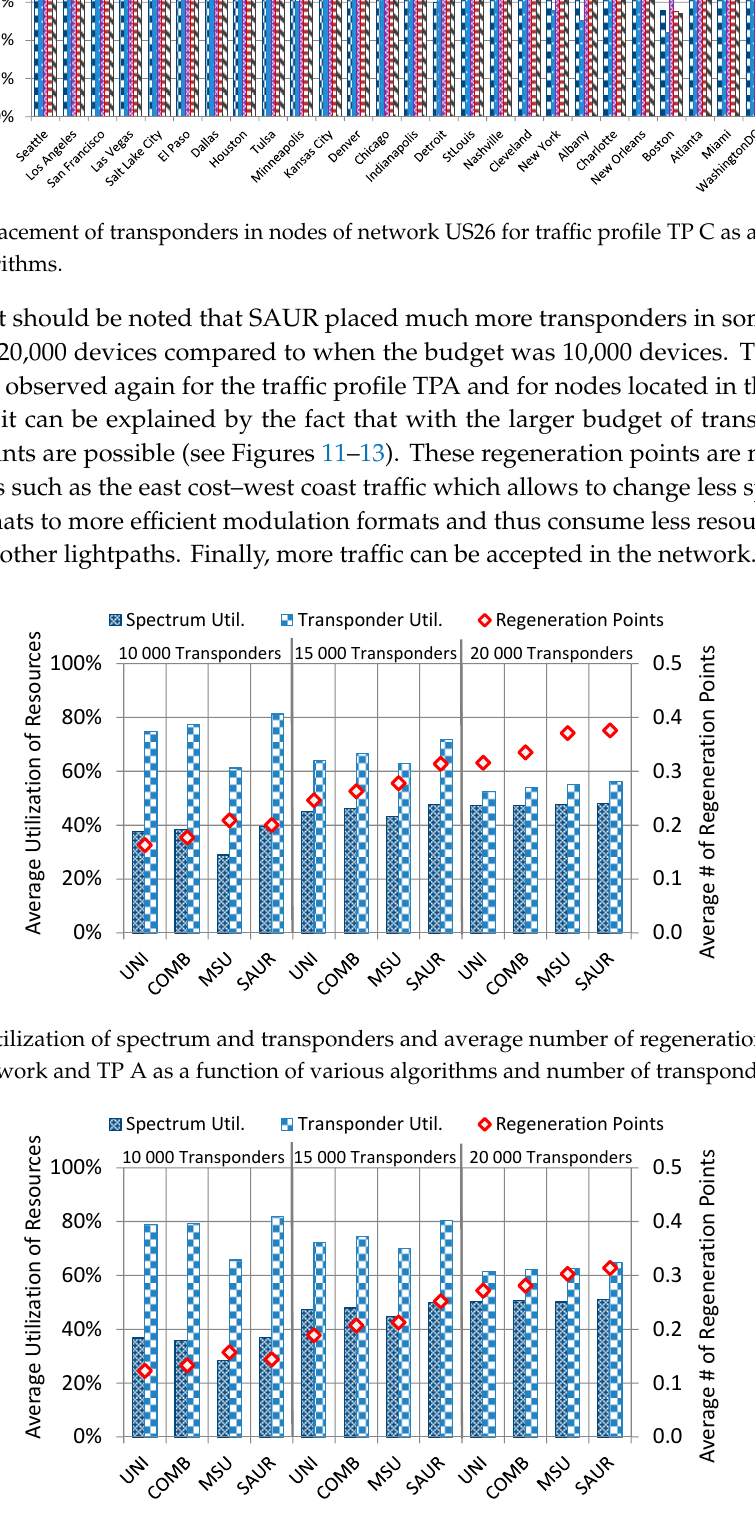
Figure 12. Utilization of spectrum and transponders and average number of regeneration points for